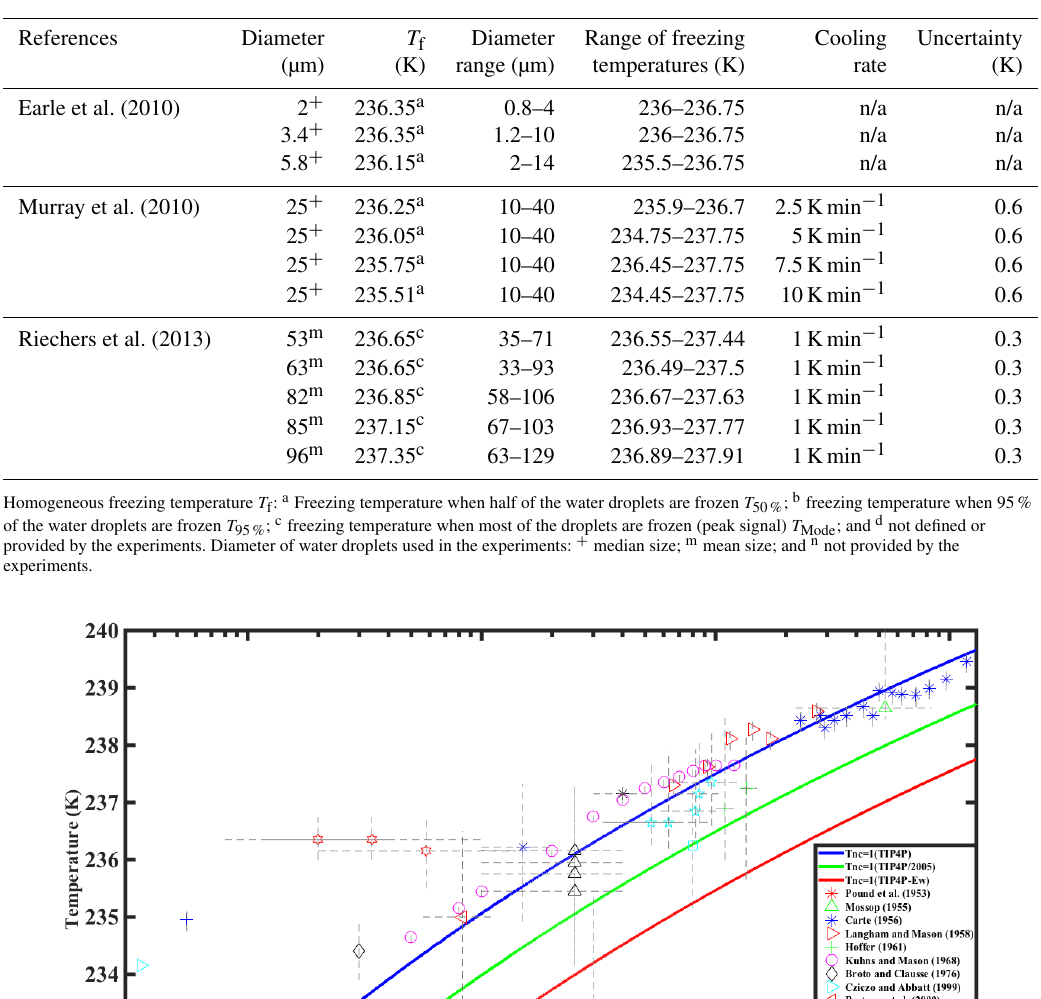
Figure 1. Freezing temperatures of pure water droplets: comparison between the approximations T N perimental data. Experimental data: the uncertainties and ranges of the drop size and the freezing temperatures are presented by the dotted lines if information is provided by the studies (details in Table 1). The approximations T N model; green line – σ i / w , e from the TIP4P/2005 model; and red line – σ i / w , e from the TIP4P-Ew model. See Sect. 2 for the definition and calculation of T N c = 1